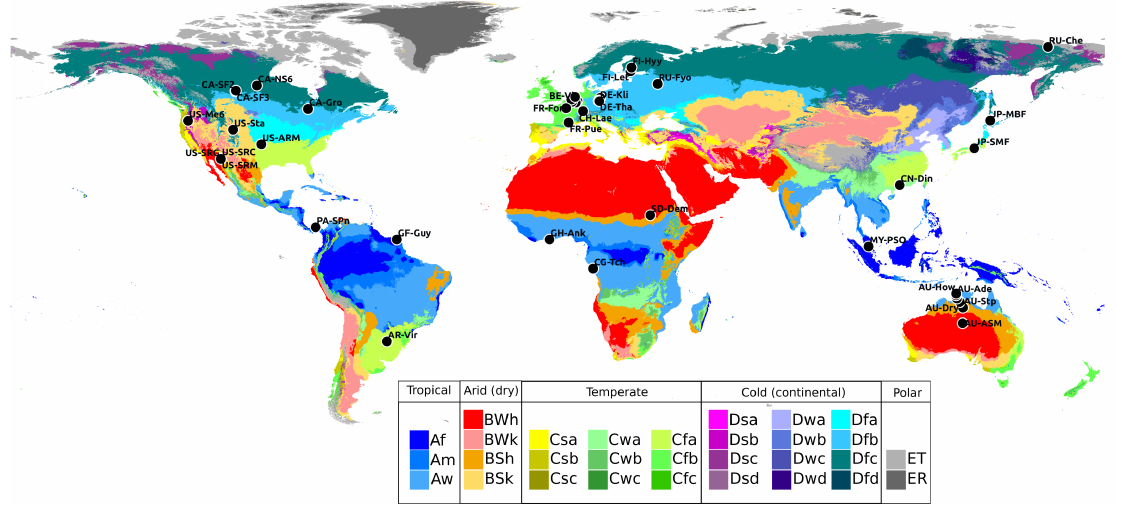
Figure 2. Location of flux towers considered in this study and the Köppen–Geiger climate classification